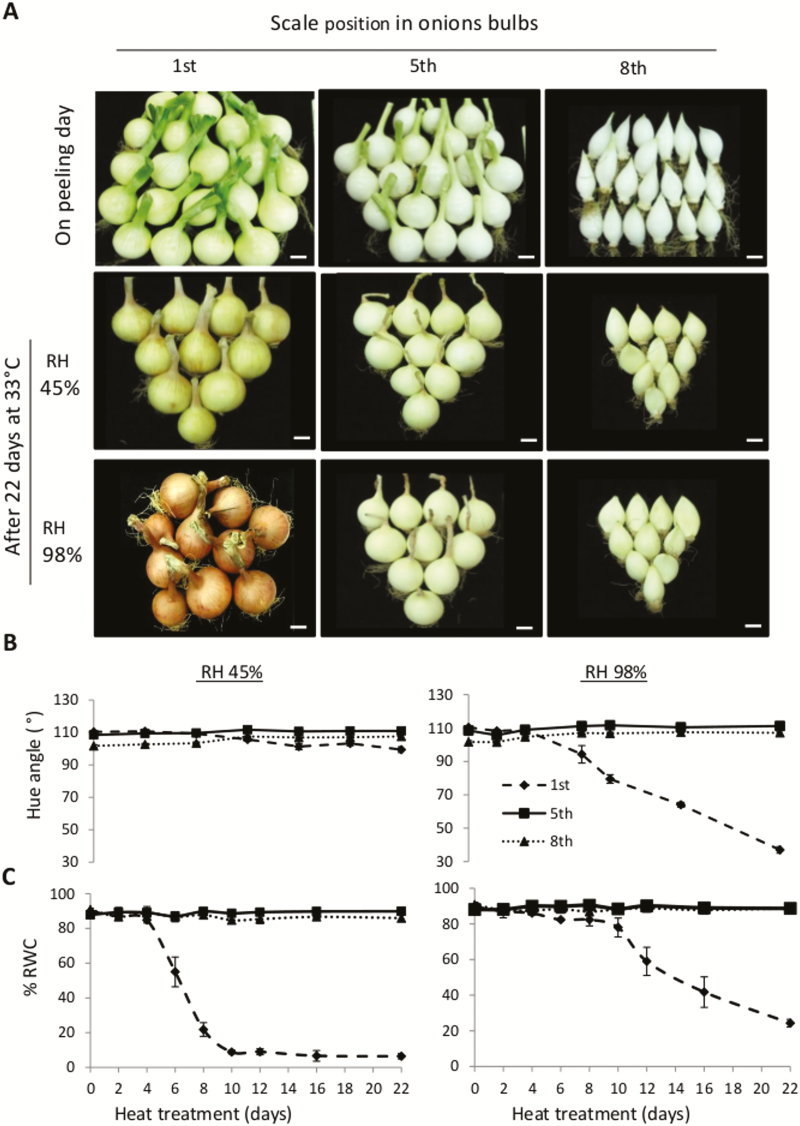
Only the outer onion scale forms dry skin during heat treatment. Onion bulbs were peeled to three depths, 1st, 5th, and 8th scales, and exposed to heat treatment at 33 °C under 45% or 98% RH. (A) Peeled onions on the day of peeling and after 22 d of heat treatment. Scale bars are 2 cm. (B) Color changes of the bulb during 22 d of heat treatment. (C) Relative water content (RWC) of the exposed scales at each peeling depth during 22 d of heat treatment. Data are means (±SE) of six replicates.